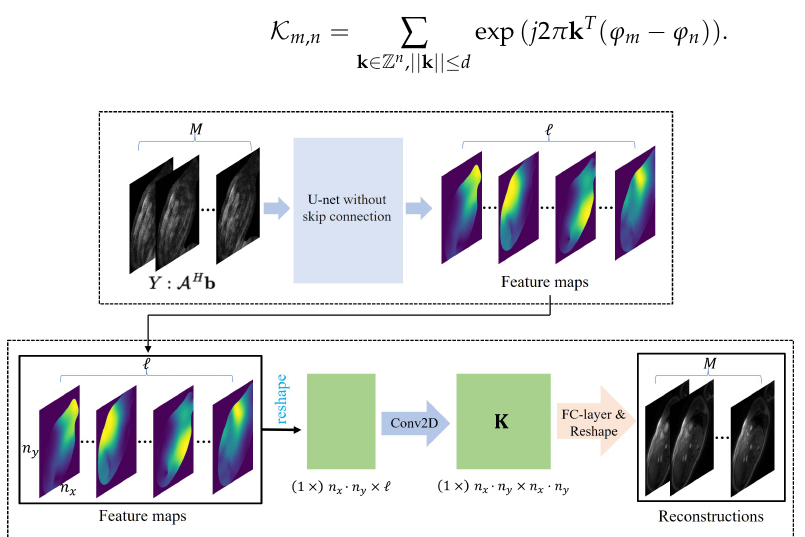
Figure 1. Illustration of the deep kernel representation. The upper part shows the feature extraction CNN. A U-net without skip connection is used to implement the feature extraction operator in this work. The lower part gives the illustration of the deep kernel representation. The feature maps, which are obtained using the CNN Φ θ , are first reshaped into the size ( 1 × ) n x · n y × (cid:96) , where n x × n y denotes the image size. Then a convolutional layer is used to obtain the kernel matrix K . The final reconstructed images in the time series are obtained using a fully-connect (FC) layer and images